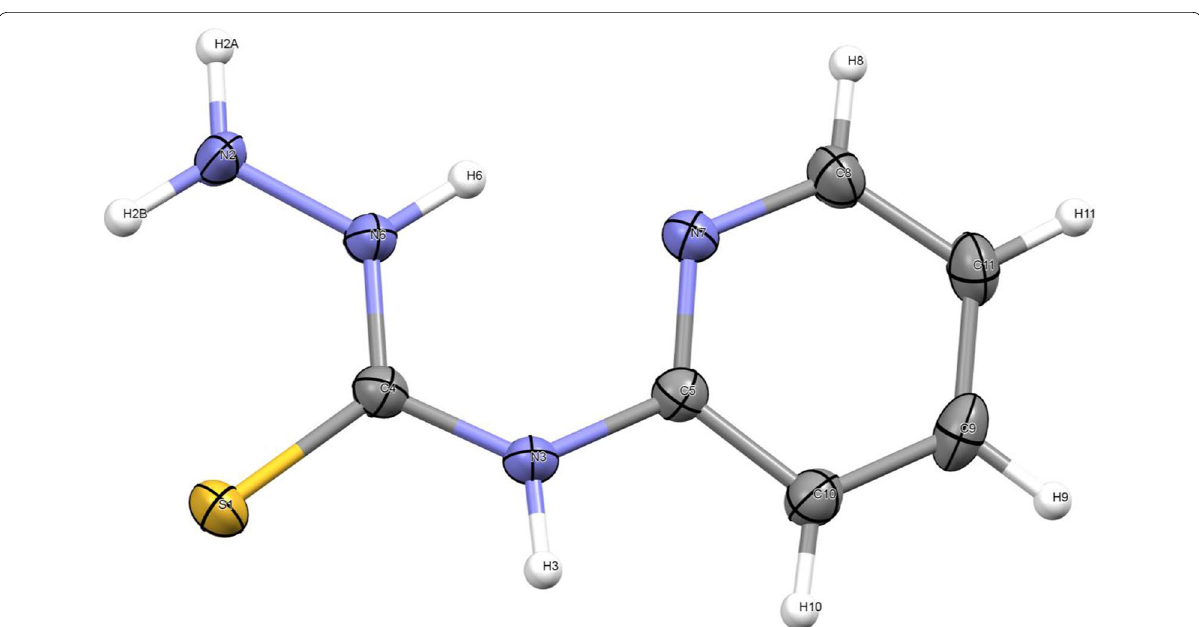
Fig. 6 Numbering scheme and atomic displacement ellipsoids drawn at 30% probability level for N